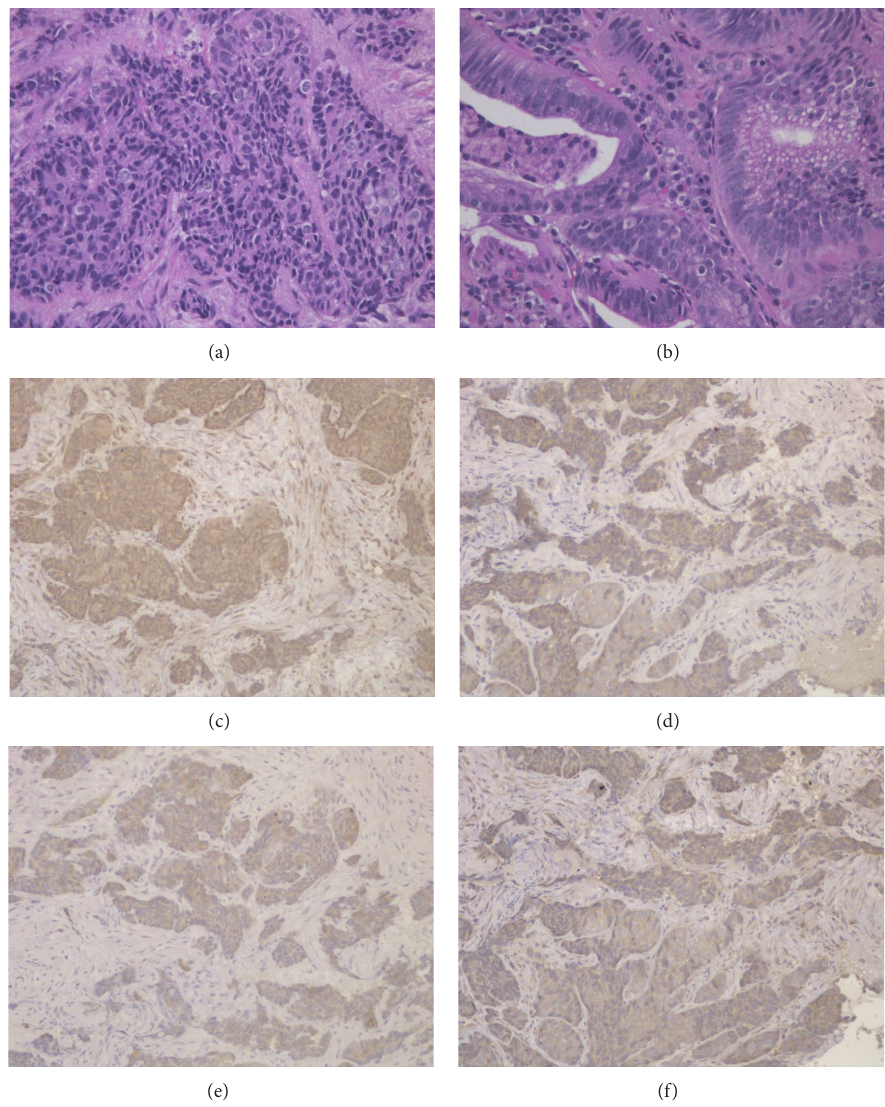
Figure 2: Proliferation of small and heterogeneous cancer cells with rich chromatin and fibrous septum with rich vessels at connective tissues was evident (hematoxylin and eosin) (a). Atypical cells forming glandular structures were evident (hematoxylin and eosin) (b).